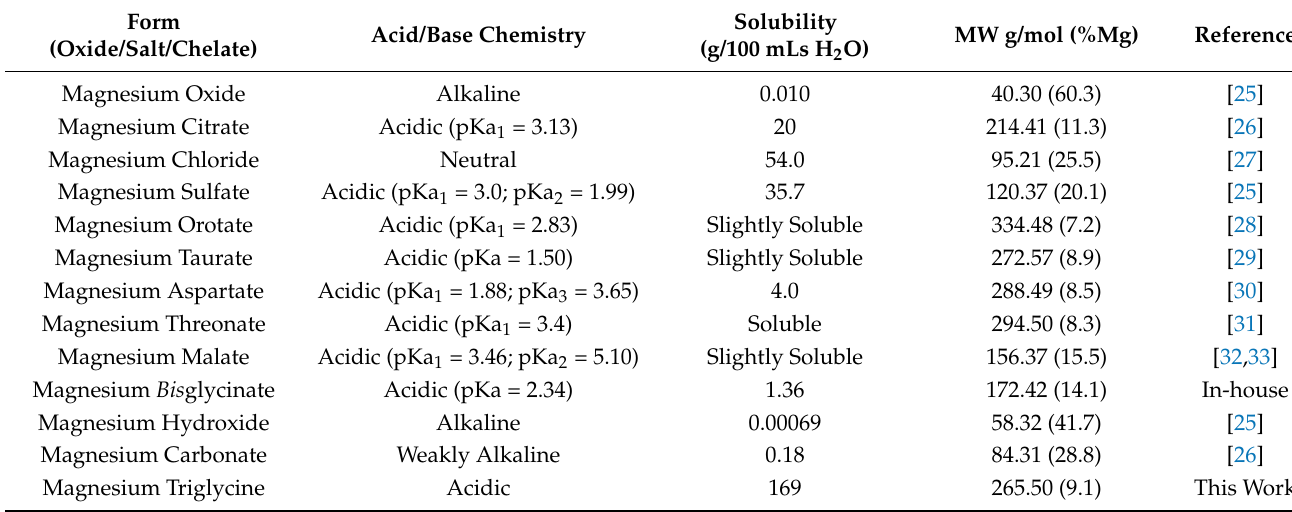
Table 1. The aqueous solubilities (g/100 mL) at room temperature, acid/base chemistry, molecular weight, and percent magnesium composition of common magnesium